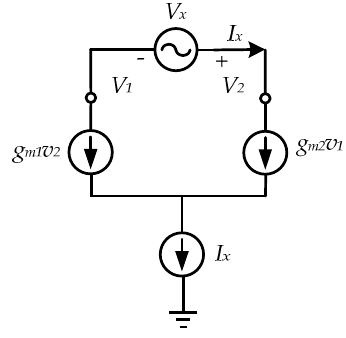
Figure 7. The small signal model of the negative resistance cell.